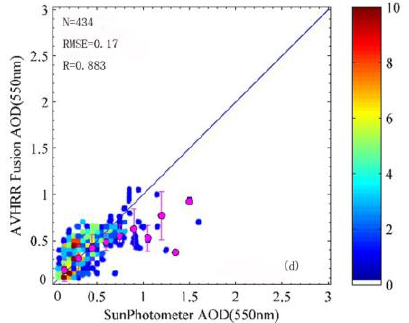
Figure 5. Scatter panels of fused AOD with Sun Photometer AOD (AERONET and